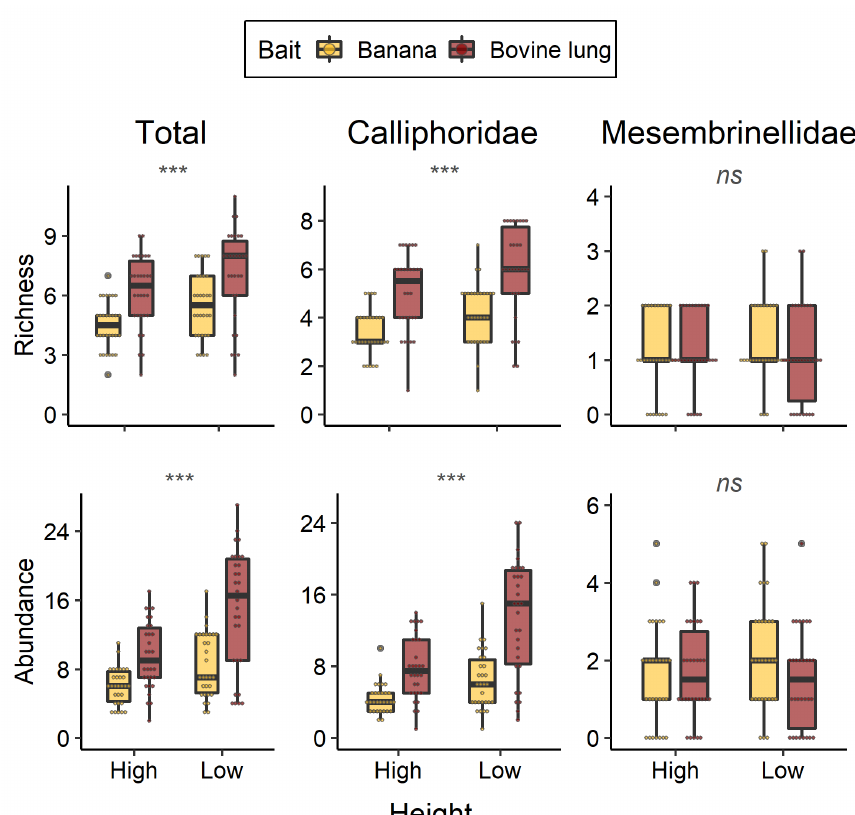
Figure 3. Analysis of species richness and abundance of flies collected in two strata (high and low) using two attractive baits (banana and bovine lung) in the Forest of Varzea in the municipality of Mazagão, Amapá State, Brazil. (Total = Calliphoridae + Mesembrinellidae; *** = significant result; ns= non-significant